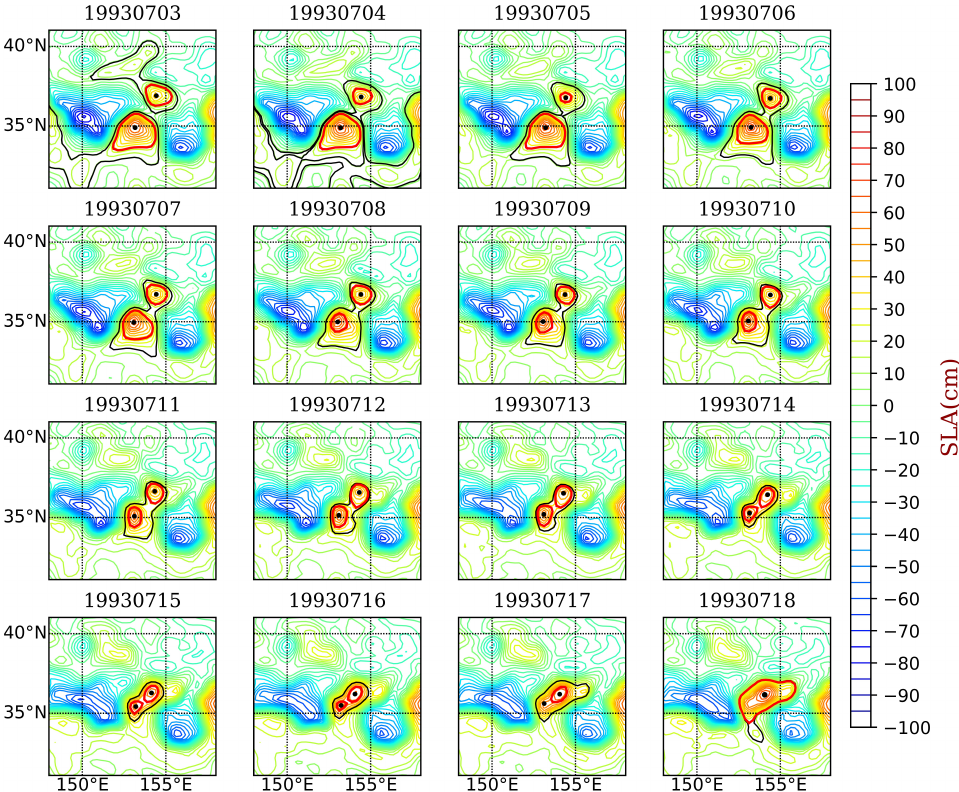
Figure 11. A merging event of anticyclonic eddies detected by our algorithm. Mononuclear ed- dies/multicore eddies and eddygroups are represented by red lines and black lines, respectively, while the eddy cores of mononuclear eddies/multicore eddies and eddy seeds are expressed by black